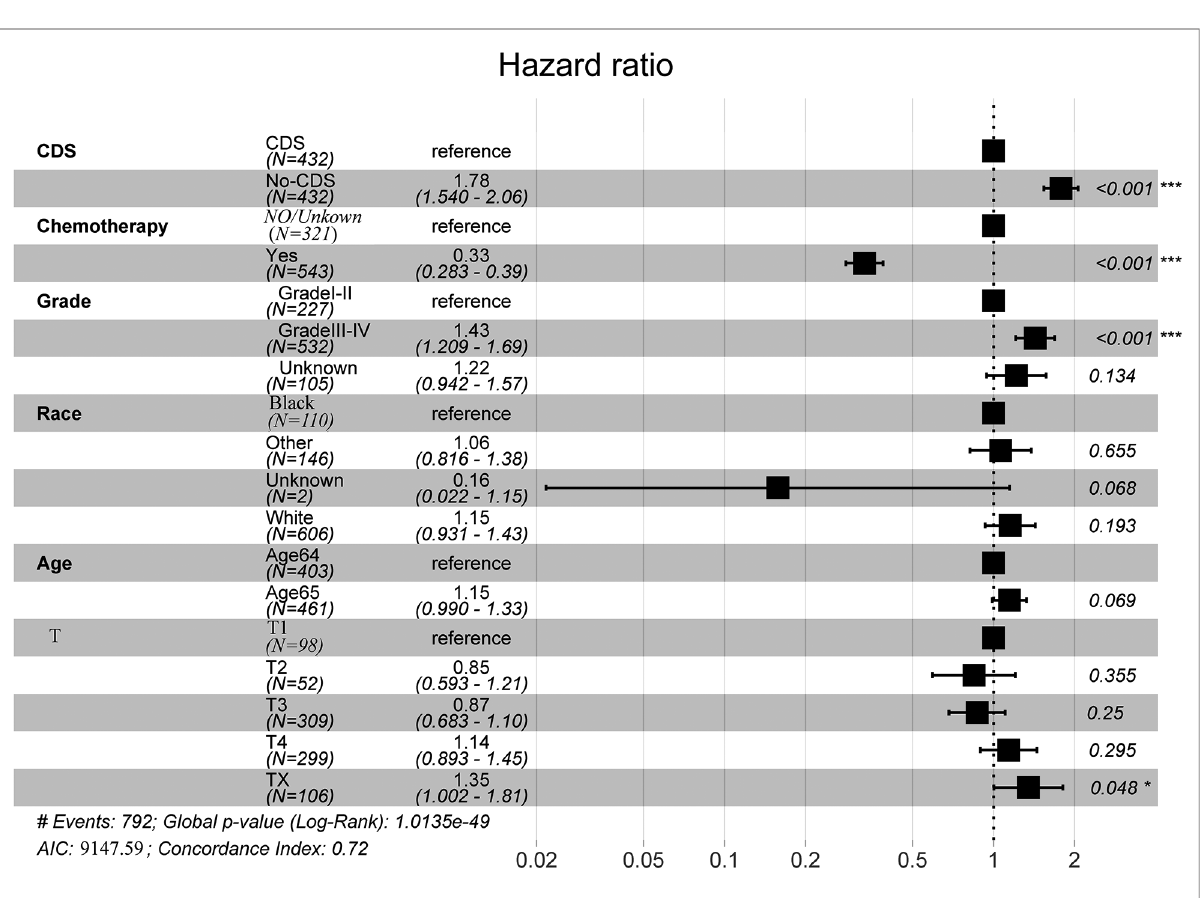
FIGURE 4 Full model average Cox proportional hazard ratios with 95% con fi dence intervals. There is a dashed line indicating the equivalent hazard ratio (HR=1) ( Table 3